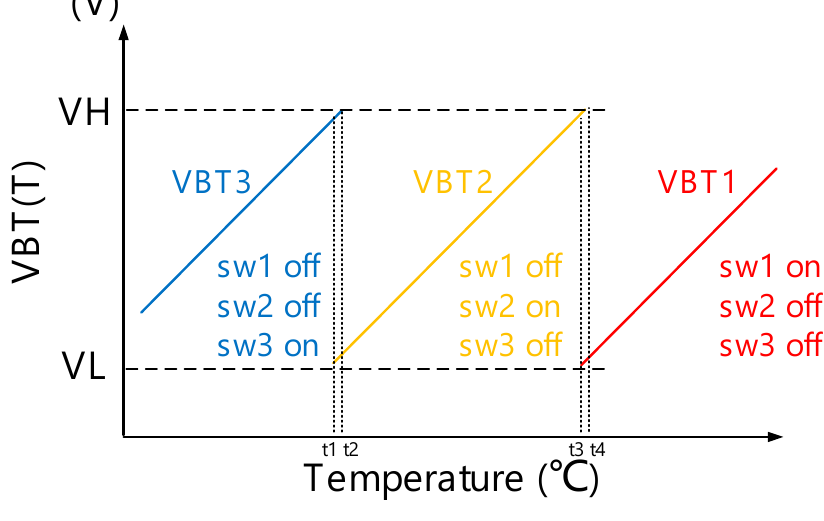
Figure 4. The illustration of VBT ( T ) .